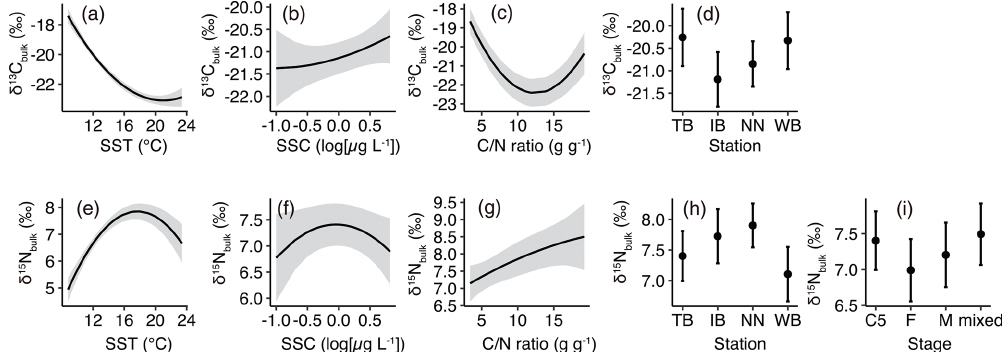
Figure 4. Responses of least-Akaike information criterion (AIC) generalized linear models (GLMs) based on least-squares mean (predicted) values. (a) δ 13 C bulk versus sea surface temperature (SST), (b) δ 13 C bulk versus sea surface chlorophyll a concentration (SSC), (c) δ 13 C bulk versus carbon : nitrogen (C / N) ratio, (d) δ 13 C bulk versus stations, (e) δ 15 N bulk versus SST, (f) δ 15 N bulk versus SSC, (g) δ 15 N bulk versus C / N ratio, (h) δ 15 N bulk versus station, and (i) δ 15 N bulk versus stages. Black lines with gray shading ( a – c , e – g ) or closed circles with vertical bars ( d , h and i ) denote the predicted values with 95% confidence limits based on the